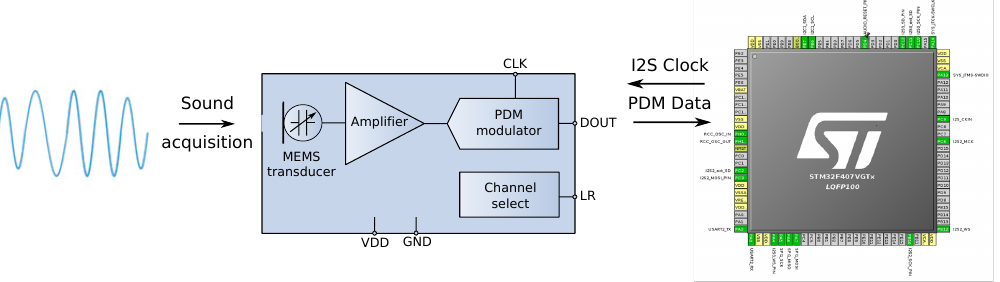
Figure 11. PDM digital microphone MP45DT02 block diagram and connection.